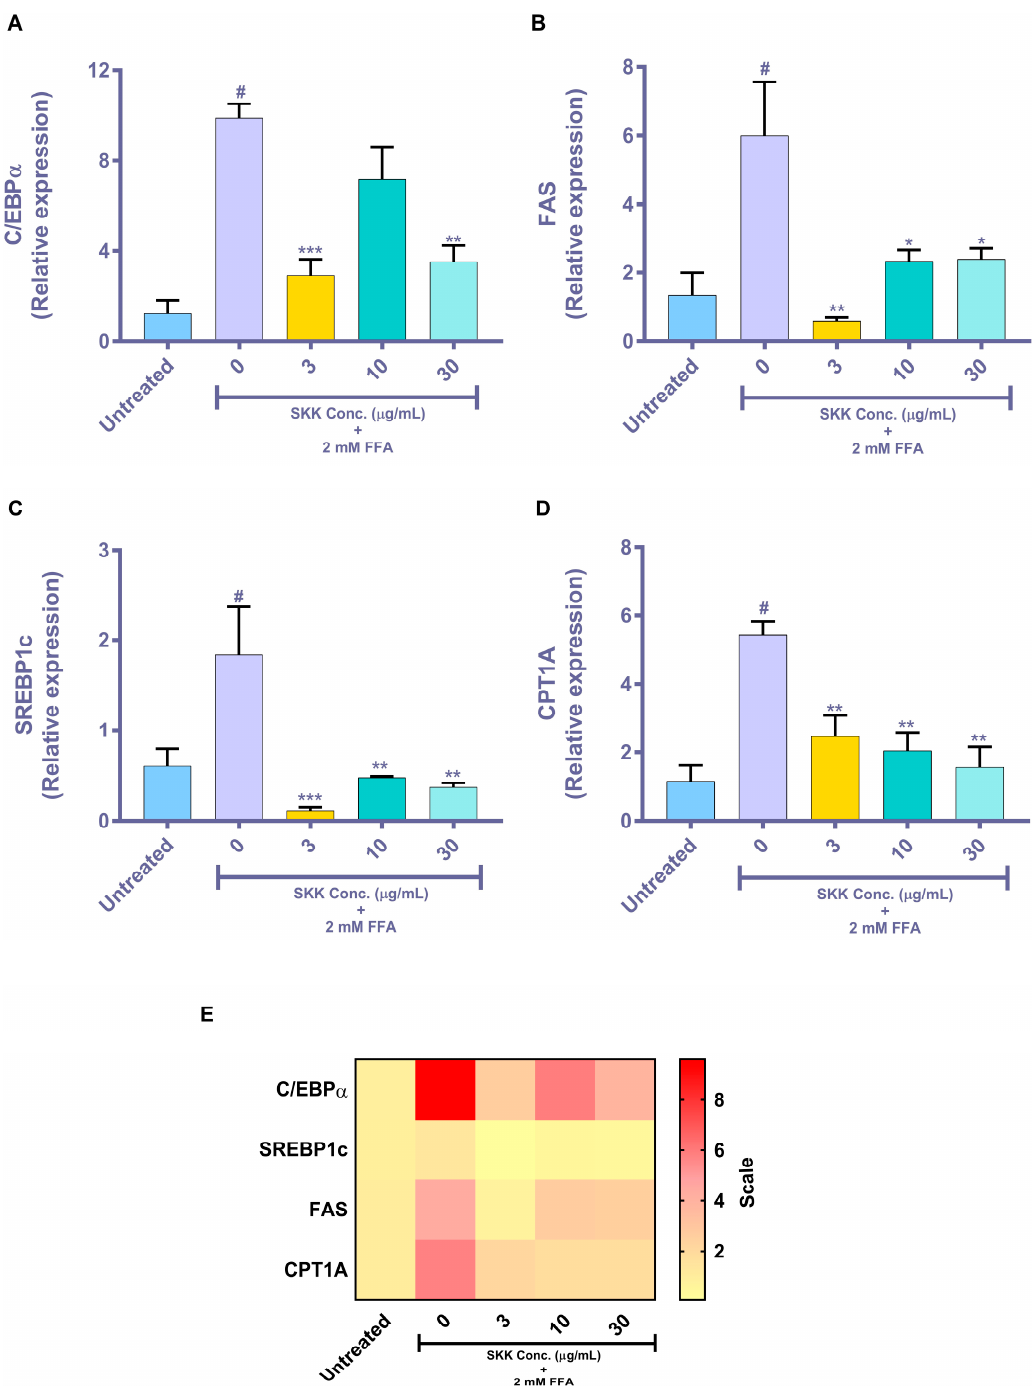
Figure 5. Gene expression analysis in HepG2 cells treated with free fatty acids and SKK. FFA-stimulated overexpression of steatosis associated genes: ( A ) C / EBP α , ( B ) FAS, ( C ) SREBP1c, and ( D ) CPT1A were observed in HepG2 cells. Pretreatment with SKK ameliorated the overexpression of genes induced by FFA treatment. ( E) Heat-map presents a visual perspective of the up- and down-regulated genes in the 2 mM FFA and SKK treated HepG2 cells. Results are displayed as mean ± SEM. All the experiments were performed thrice in duplicate. For statistical analysis, one-way ANOVA with Dunnett’s multiple comparisons was performed, where untreated control vs. 0 µ g / mL = # p value < 0.01 and SKK test concentrations vs. 0 µ g / mL = * p value < 0.05, ** p value < 0.01 and *** p value <